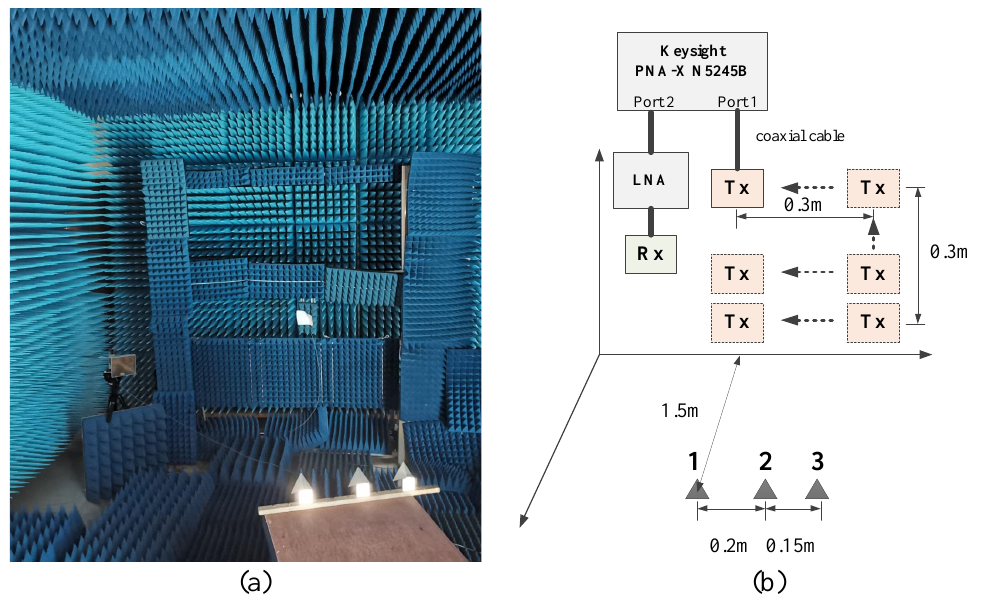
Figure 16. Scenario of imaging experiment of SRFS-MSCI in microwave anechoic chamber. ( a ) The real-world scenario. ( b ) The geometrical scenario